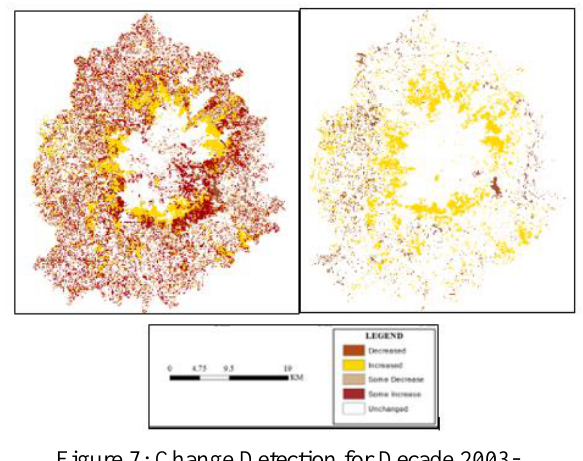
Figure 7: Change Detection for Decade 2003- 2013(Lucknow)